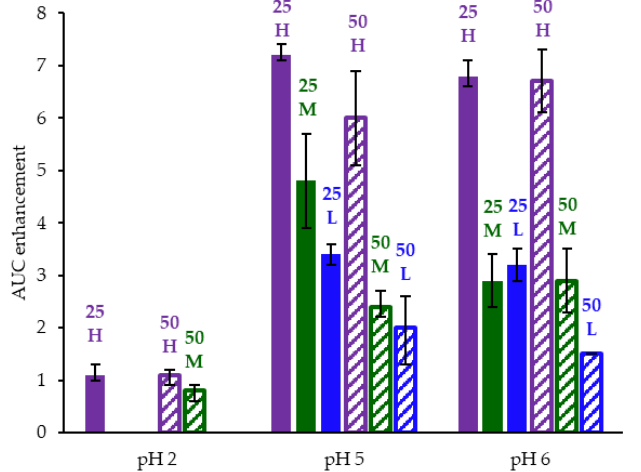
Figure 4. AUC enhancement for ASD intermediates tested in gastric to intestinal transfer dissolution tests using a Pion µDiss Profiler. X -axis labels represent starting gastric pH. AUC enhancement = AUC(ASD)/AUC(crystalline acalabrutinib), reported as average with error bars representing the range of two measurements.